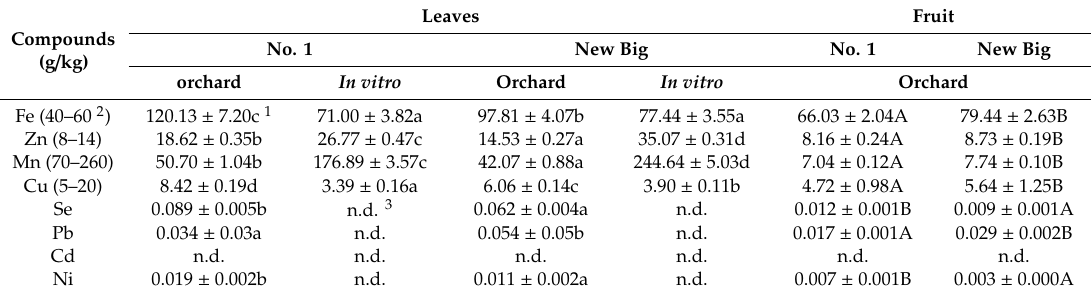
Table 2. Average values of microelements in leaves and fruit of two cultivars of goji cultivated in orchard and in vitro